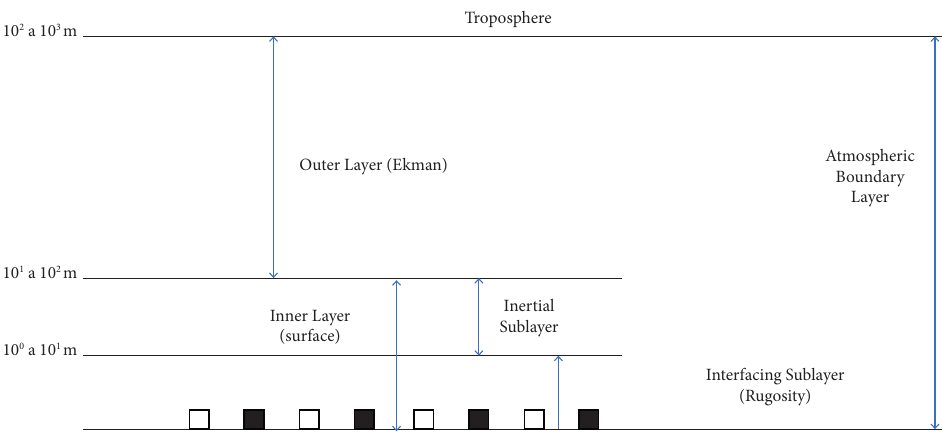
Figure 3. Atmospheric boundary layer structure (Adapted from Garrat